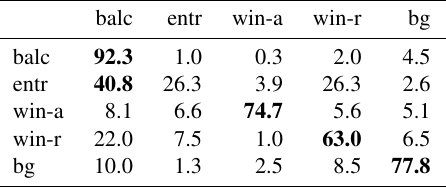
Table 5: Confusion matrix using aggregates of A 2 and A 3 , accu- racy 74 . 6 , see Table